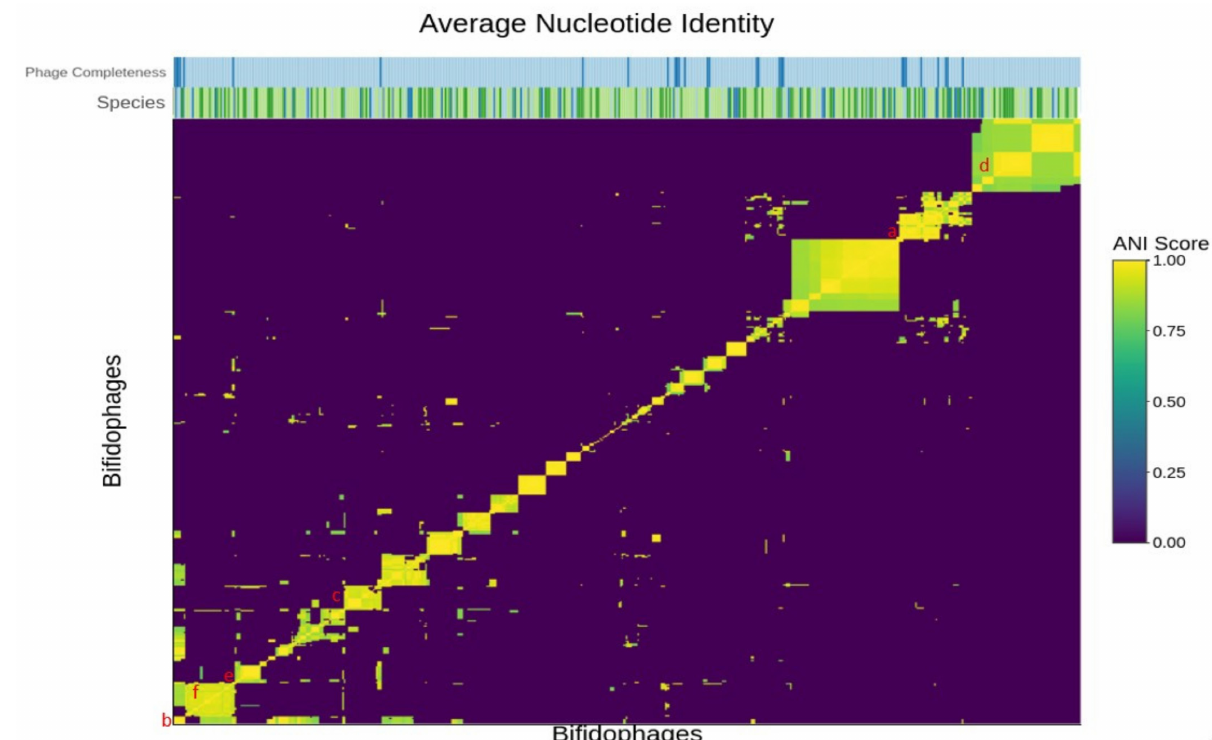
Figure 1. ANI heatmap produced by heatmaply. Yellow boxes in the heatmap signify prophage sequences with high levels of nucleotide similarity to each other. There are clusters of high similarity at both intra- and inter-species levels. The rowside legend indicates the degree of predicted completeness of the predicted prophages. Bifidophages predicted to be likely complete or complete are highlighted in dark blue on the “Completeness” column key. Suspected partial or likely remnant bifidophages are highlighted in light blue. The red letters a to f represent the six clusters highlighted in Figure